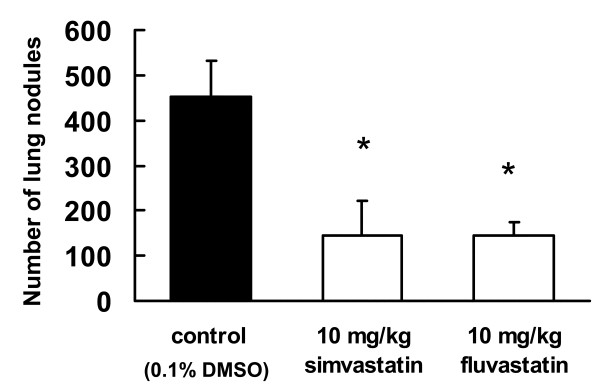
Inhibitory effect of oral administration of statins on lung metastasis. B16BL6 cells were injected into the tail veins of syngeneic C57BL/6J mice. Mice were treated daily from days 1 to 14 with 10 mg/kg fluvastatin or simvastatin. After 14 d, visible nodules that had metastasized to the lungs were counted. The results are expressed as the mean ± SD for 9 mice.